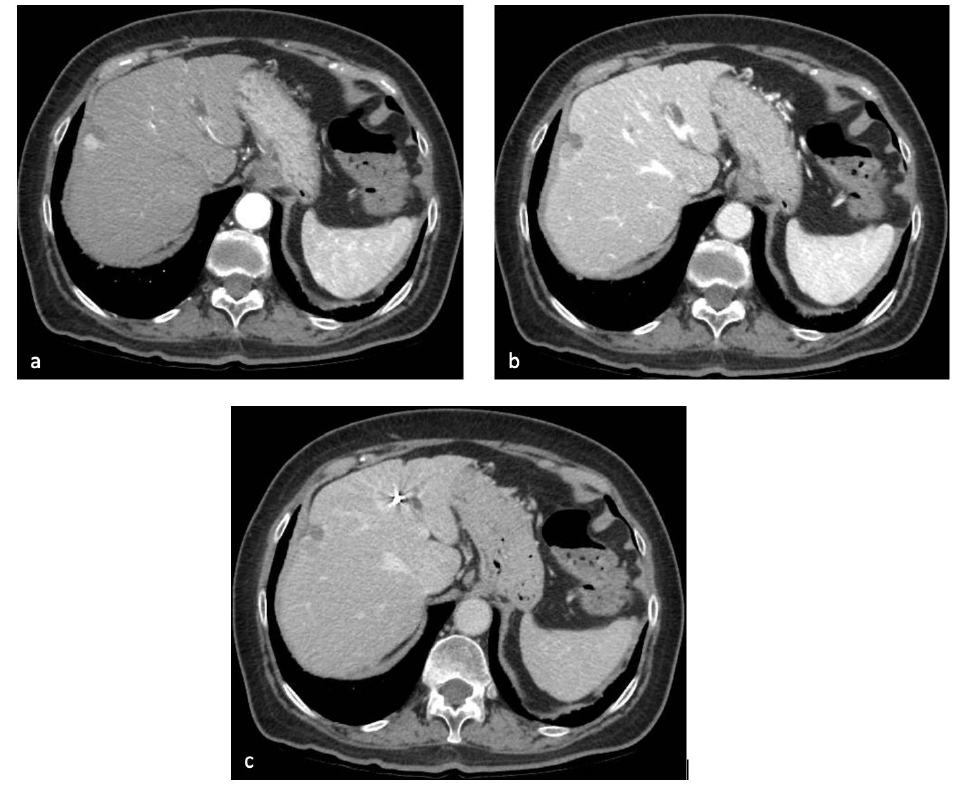
Figure 2. Contrast-enhanced CT of the upper abdomen in the patient discussed in Figure 1. After administration of iodinated contrast agent, the subcapsular lesion showed arterial hyperenhancement ( a ), with progressive wash-out in the portal-venous ( b ) and delayed ( c ) phase.